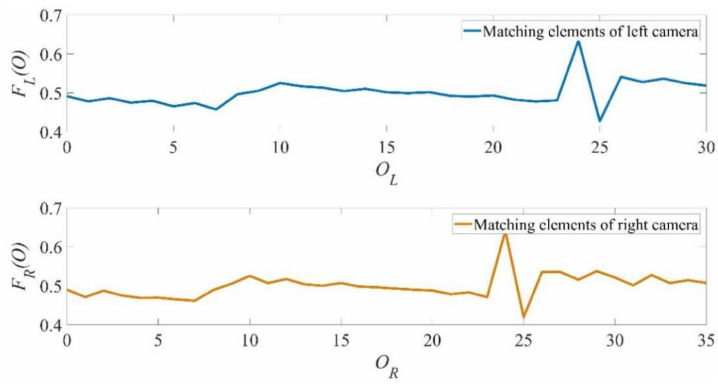
Figure 12. Feature-point-matching elements.